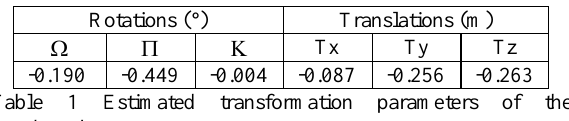
Table 1 Estimated transformation parameters of the benchmarks